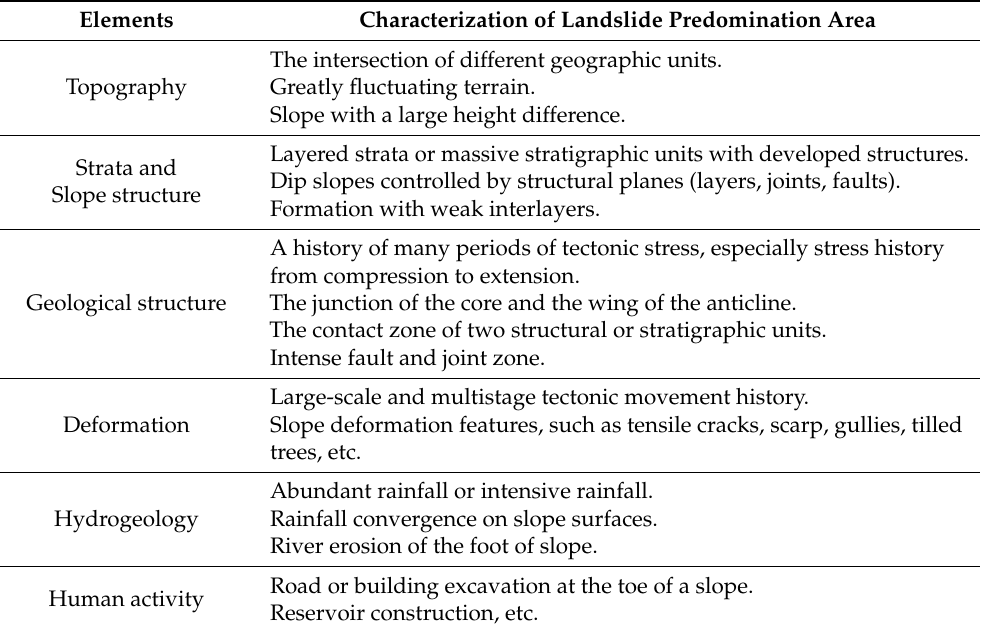
Table 1. Landslide predomination area delineation condition.